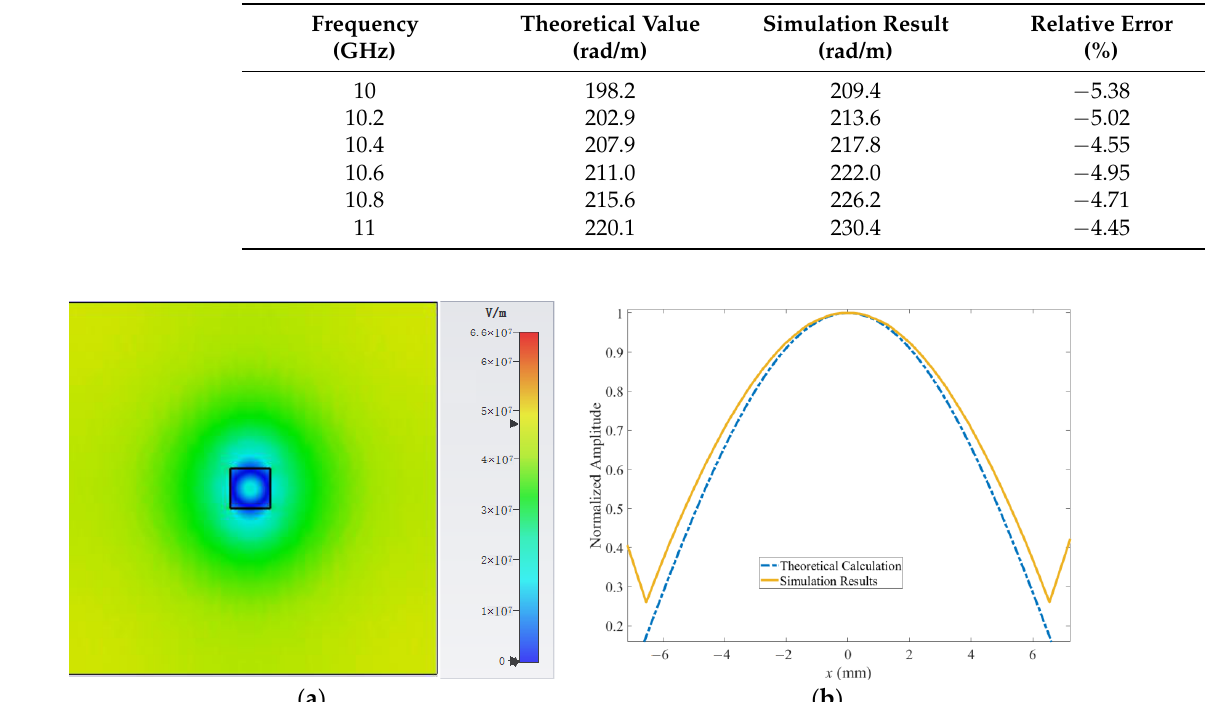
Table 2. Theoretical and simulated real parts of longitudinal phase constants for leaky mode.